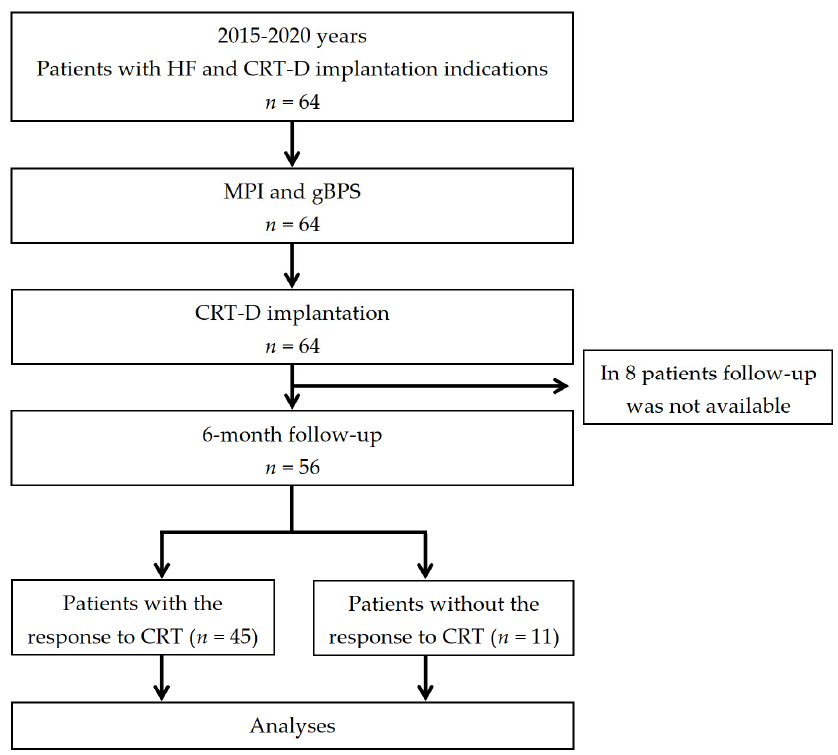
Figure 1. Study flowchart: HF—heart failure; MPI—myocardial perfusion imaging; gBPS—gated blood ‐ pool SPECT; CRT—cardiac resynchronization therapy; CRT ‐ D—CRT devices with the defib ‐ blood-pool SPECT; CRT—cardiac resynchronization therapy; CRT-D—CRT devices with the defibril- rillation function. lation